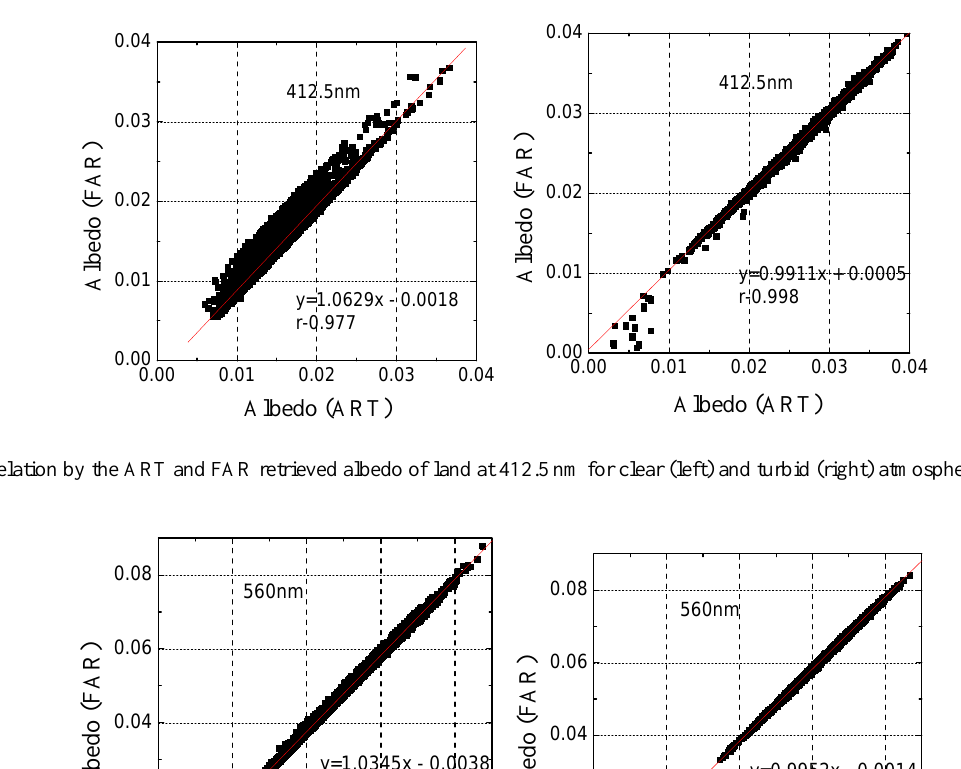
the retrievers. The results that the AOT retrieved by different groups with different techniques are given in Kokhanovsky et al. (2010a). The results of such retrieval for three aerosols mod- els (Continental, Water-soluble, Oceanic) are depicted in Fig. 21, dependent on the reference AOT. The phase func- tions for these aerosol models at λ = 550 nm are given in Fig. 19. As seen, these phase functions are very different, 100 ◦ –150 ◦ typical for the satellite remote sensing. It is clear that just this difference provides such a discrepancy of the